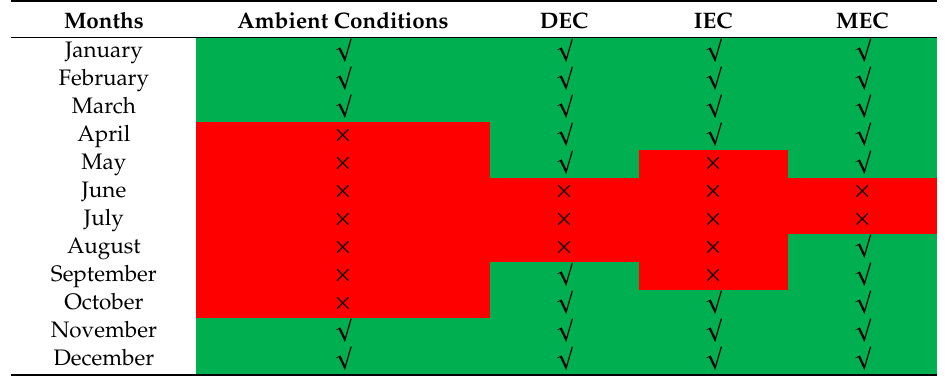
Figure 14. Psychrometric representation of the performances of EC systems for the months of April to October. Table 1. Applicability / feasibility of the EC systems for the climatic conditions of Multan. The results are based on numerical values of